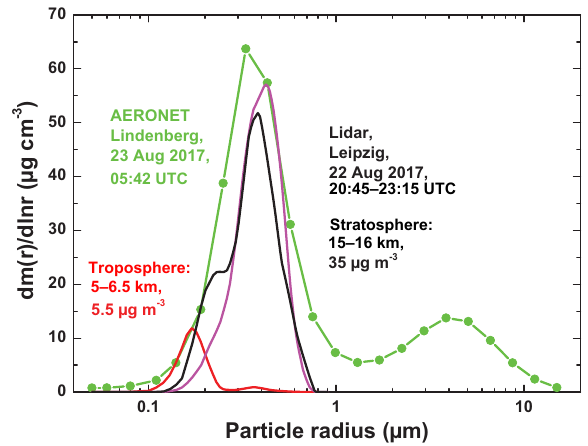
Figure 4. Particle mass size distribution derived from column (tro- pospheric + stratospheric) AERONET observations at Lindenberg, 180km northeast of the lidar site, in the morning of 23 August 2017 (green) and obtained from the inversion of lidar-derived optical properties in the tropospheric layer (red) and stratospheric layer (black, magenta). Small particles prevailed in the tropospheric layer and comparably large accumulation-mode particles dominated in the stratospheric layer. The black and magenta curves are obtained by assuming spherical and spheroidal particle shapes in the lidar data inversion,